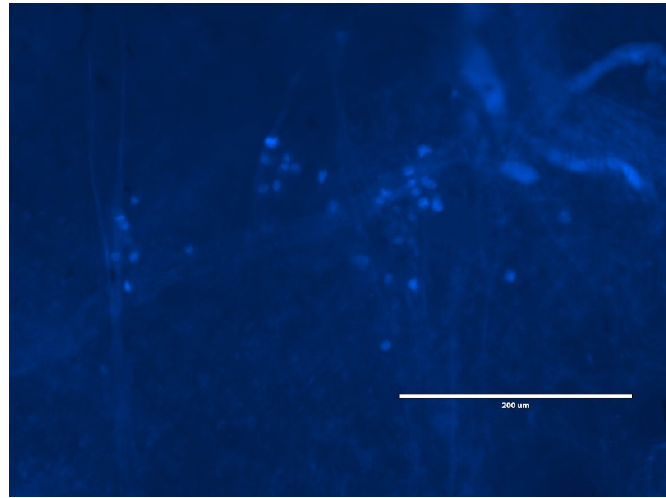
Figure 3. Sample microphotograph of Hoechst 33258 stained PC12 cells on the surface of the CorMatrix; scale bar: 200 µ m.